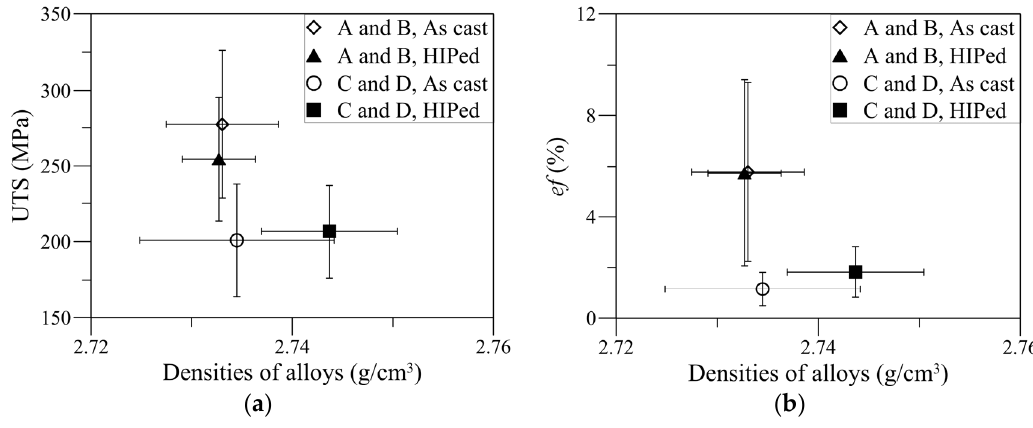
Figure 15. Effect of HIPing on mechanical properties for alloys A and B combined and alloys C and D, combined. Both figures are showing the effect of HIPing and ( a ) is relating UTS to density and ( b ) is showing e f in relation to density.